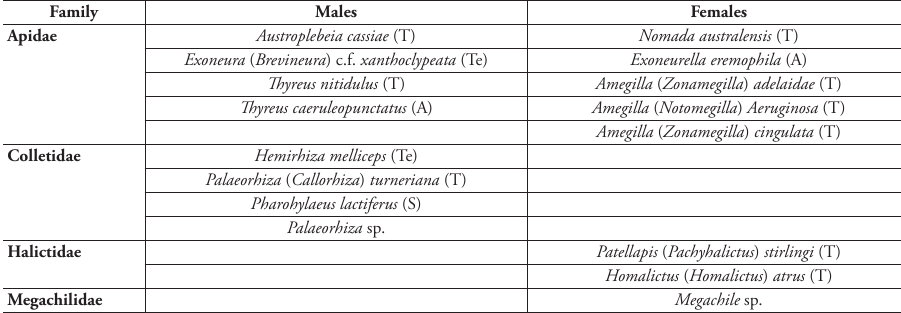
Table 2. The ‘diurnal’ bee species that, according to our PCA (Fig. 4), are associated with facultative low- light foraging species. Table is broken up by sex and family. The climatic zone in which is species most frequently has been collected is indicated in parentheses where A, S, T, and Te refer to arid, subtropical, tropical and temperate respectively (Suppl. material 6, Fig. S5). Most species did not include both male and female representatives – this was based on availability of specimens and size-calibratable images. The only species in the table with both sexes examined is E. xanthoclypeata